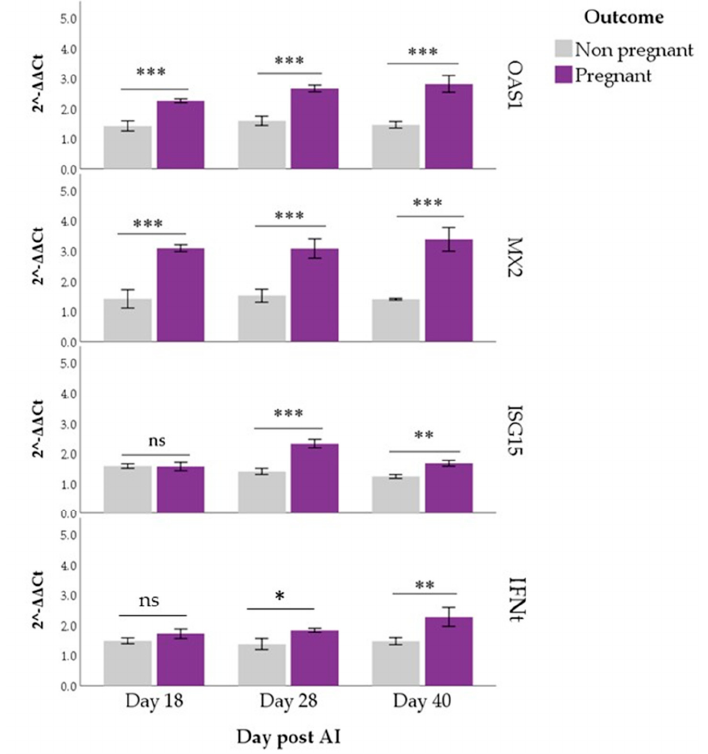
Figure 1. OAS1 , MX2 , ISG15 and IFNt expression in PBMCs of pregnant and non–pregnant buffaloes. Asterisks indicate differences in expression between the Pregnant and Non-pregnant groups for each gene and each day post-artificial insemination (AI; * p < 0.05, ** p < 0.01, *** p < 0.001).